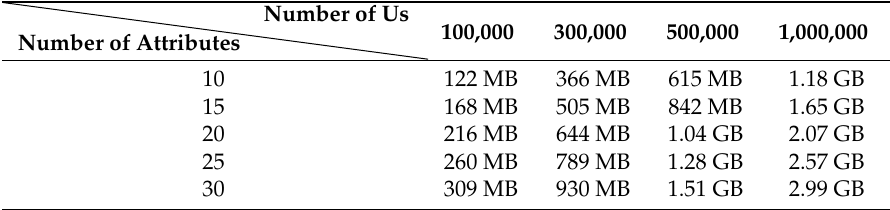
Table 3. Data Size Saved in the CKA.